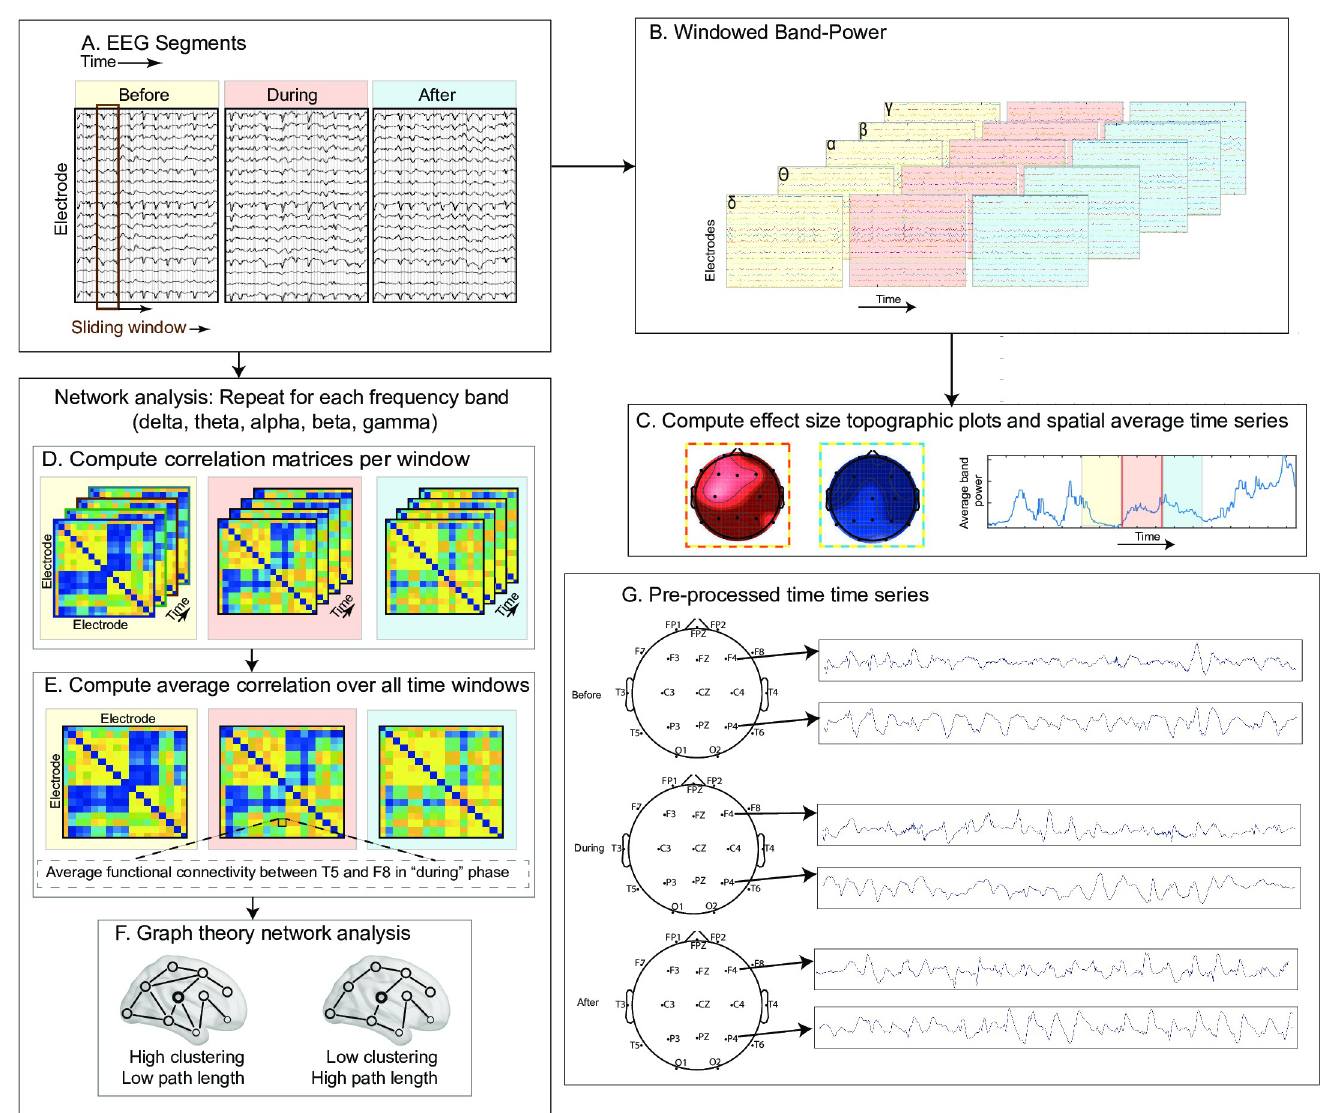
Fig 1. Analysis Pipeline (A-F). (A). Pre-processed EEG signal in “before”, “during” and “after” states (B). Band-power computed across all the channels for every sliding window (C). Windowed band-power across all the channels used for topographic and spatial average time series plots. (D-E) windowed correlations matrices for every sliding window and then averaged over time (F). Illustrative networks demonstrating path length and clustering coefficient. (G) Pre-processed EEG time series for two example locations for Patient